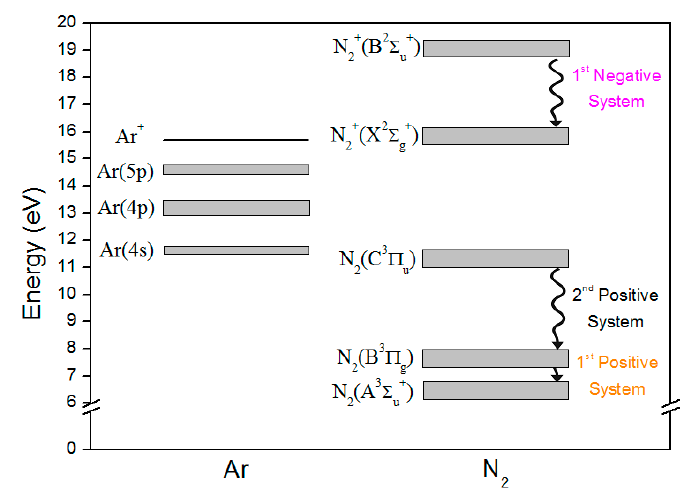
Figure 4. Main energy levels for the Ar atom and the N 2 molecule.